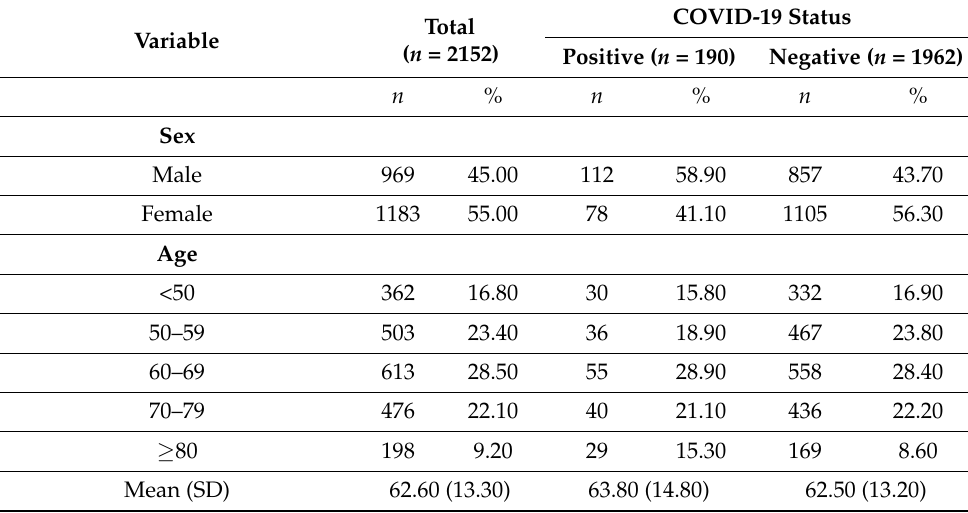
Table 1. Demographic and cancer characteristics of COVID-19 positive and negative cancer